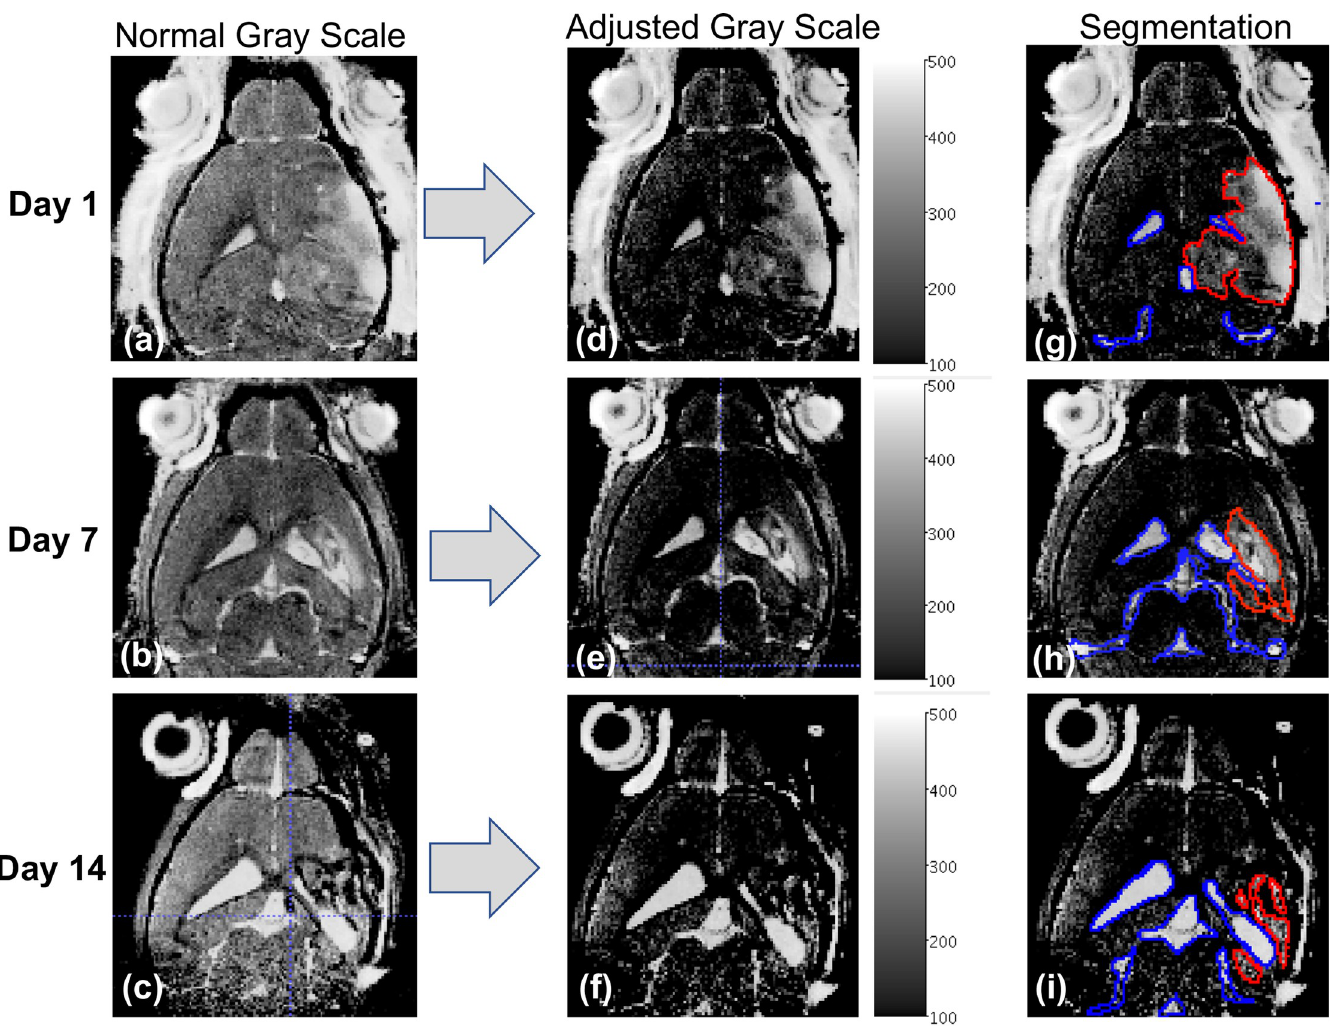
Fig 2. Schematic approach to define the threshold window for segmentation of ‘lesion area’ and the ventricular space. MR images corresponding to a TBI mouse at 1, 7, and 14 days post-TBI are shown. The schematic approach to define the threshold window for segmentation of ‘lesion area’ (RED outline) and the ventricular space (BLUE outline) is depicted with the first column showing the MR images at different time points in normal gray scale with contrast optimized for whole brain visualization. The center column depicts the corresponding images in an adjusted threshold scale (S.I.~100–500 a.u.) that facilitates visualization of both lesioned area and ventricular space. The last column superimposes the segmentation of regions of interest with RED outlining the lesion area and BLUE outlining the ventricular space. The progressive ventricular enlargement and corresponding reduction of the lesion area are clearly evident and are consistent with loss of brain tissue.